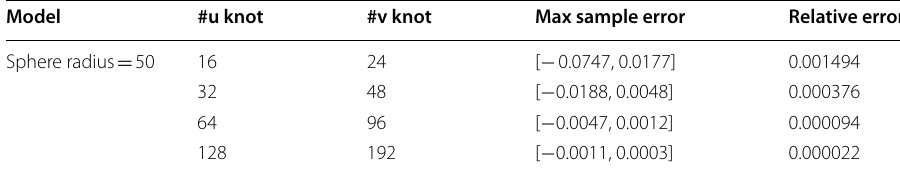
Table 1 Statistics of interpolation errors Model